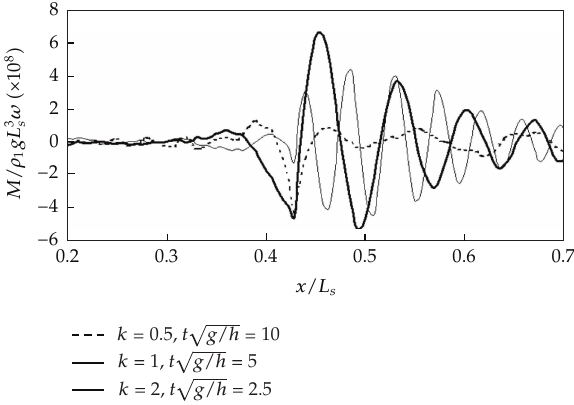
Figure 9: Surface and interface profiles at the time t where B s (cid:7) 500.0Nm 2 ; L s (cid:7) 35.0m; L p (cid:7) 5.0m; k (cid:7) 1.0; N (cid:7) 2. The point load has come to the position which the mark (cid:2) indicates.